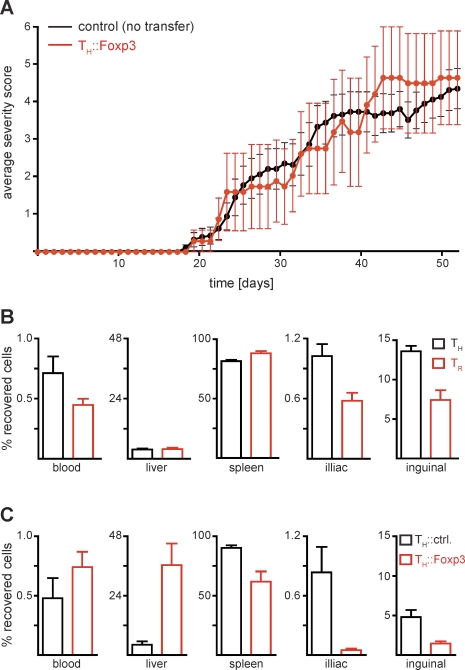
Polyclonal TH::Foxp3 Cells Fail to Suppress CIA and Exhibit Altered Homing Behavior(A) Arthritis was induced on day 0 by immunization with cII in CFA. Mice that did not receive any further treatment (black, n = 27) and mice that received 1 × 106 TH::Foxp3 cells 1 d prior to immunization (red, n = 7) are shown. The average arthritis scores of all mice in the two groups are shown.(B and C) Comparison of the homing behavior of (B) CFSE-labeled TH (black) and TR (red) cells and (C) GFP-expressing TH::control (black) and TH::Foxp3 (red) cells. A total of 1 × 106 cells were transferred into each mouse (TH, n = 3; TR, n = 3; control, n = 4; and Foxp3, n = 6), and the tissues were analyzed 48 h later by flow cytometry. The diagrams represent the percentage of cells in each tissue, calculated from the total number of cells recovered in all tissues together (1.2 × 105 ± 0.1 × 105 TH cells and 1.1 × 105 ± 0.2 × 105 TR cells; 8.3 × 104 ± 2.7 × 104 TH::control cells and 5.1 × 104 ± 0.9 × 104 TH::Foxp3: cells; values ± SEM). Error-bars represent the SEM.